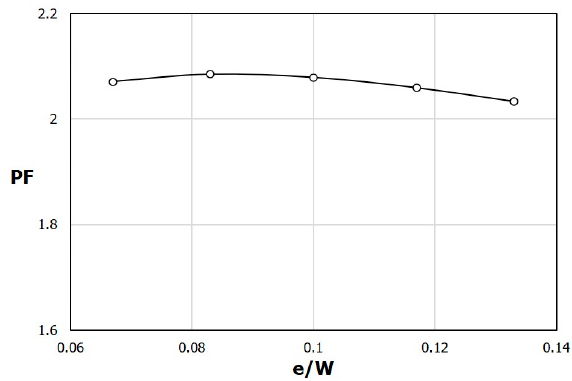
Figure 12. Variation of PF with e/W (h/H = 0.5).